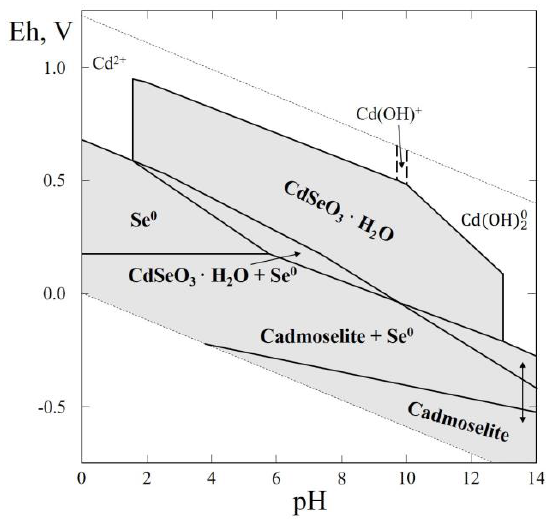
Figure 8. Eh–pH diagram of the OHSeCd (Cd–Se–H 2 O) system at 25 ◦ C and the activities of the components: a Σ Se = 10 − 4 , a Σ Cd = 10 − 2 . The dotted lines are the boundaries between fields of Cd 2+ , Cd(OH) + and Cd(OH) 20 .